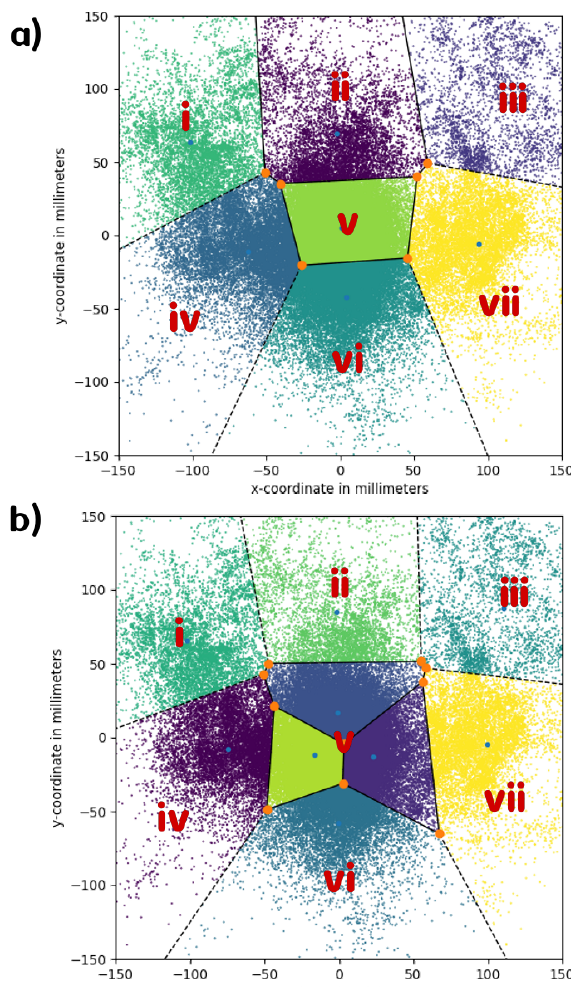
Figure 5: a) Graphical output of the k -means clustering algorithm with 7 clusters. One can observe that there are two mid-to-low peripheral sections combining the sections ‘4’ and ‘7’, as well as ‘6’ and ‘9’ from the manual coding grid. b) Graphical output of the k -means clustering algorithm with 9 clusters. Here, rather than differentiating the lower peripheral clusters into ‘4’ and ‘7’, and ‘6’ and ‘9’ as in the manual coding grid, two additional sections in the center area